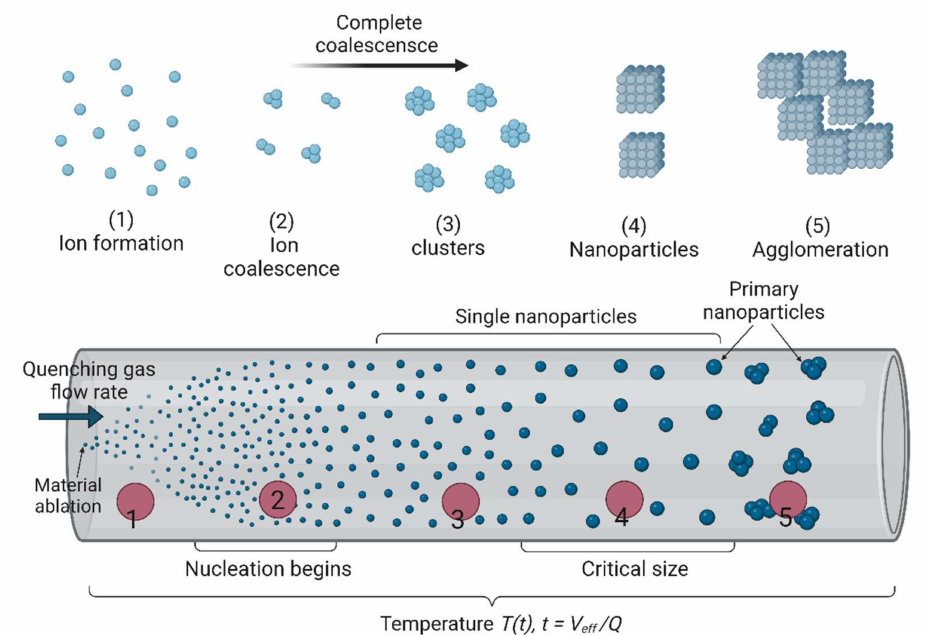
Figure 6. Schematic showing the synthesis of single and agglomerated aerosol nanoparticulates starting from material ablation at atmospheric pressure. Figure created with